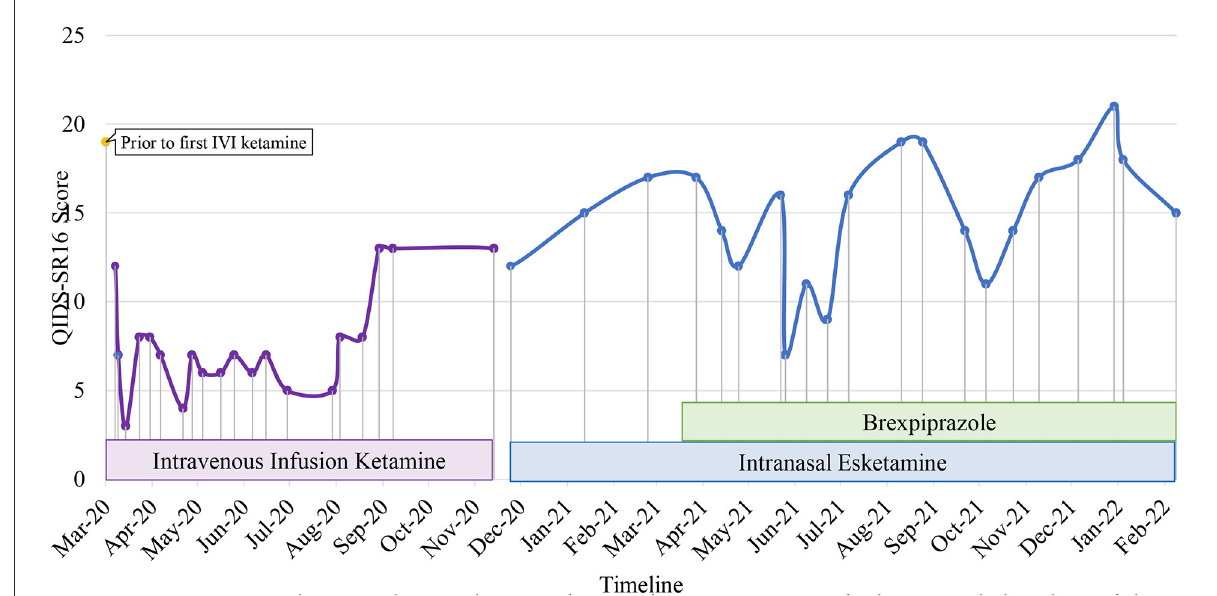
FIGURE3 Case 3 timeline for longitudinal course of treatment response. Patient 3 is a single woman in her 30s’ with a current diagnosis of treatment-resistant unipolar depression with physical co-morbidity of bilateral normal tension glaucoma with high myopia. Brexpiprazole was initiated at the dose of 0.5mg and titrated to a maximum of 3.5mg in combine with intranasal esketamine 84mg fortnightly. Co-medications include zolpidem 10mg, mirtazapine 45mg, quetiapine 800mg, vortioxetine 20mg, and clonazepam 6mg. There was an overall reduction of depressive symptoms after initiation of ketamine, albeit with fluctuations of these symptoms, perpetuated by psychosocial stressors over the longitudinal course of treatment. She reported more sustainable improvement in her energy, personal care, interpersonal and occupational functioning after brexpiprazole was added to address this